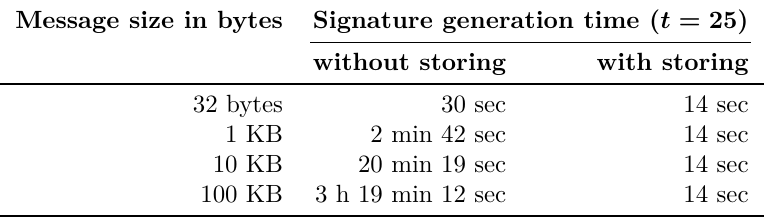
Table 7.1: Signature generation time for a message hash with 2 25 different counter values, with and without storing the first 2 + b M len + 8 / 64 c SHA-256